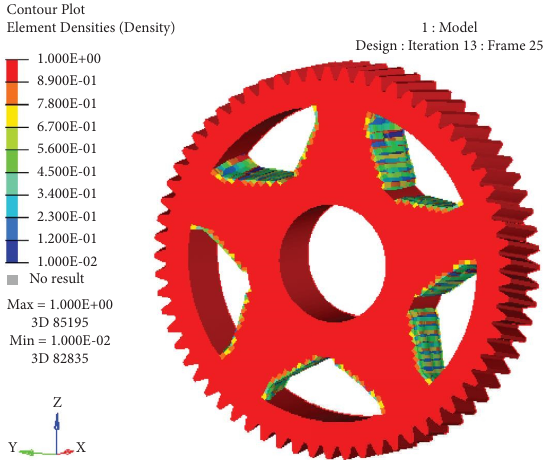
Figure 5: Schematic of static topology optimization results.